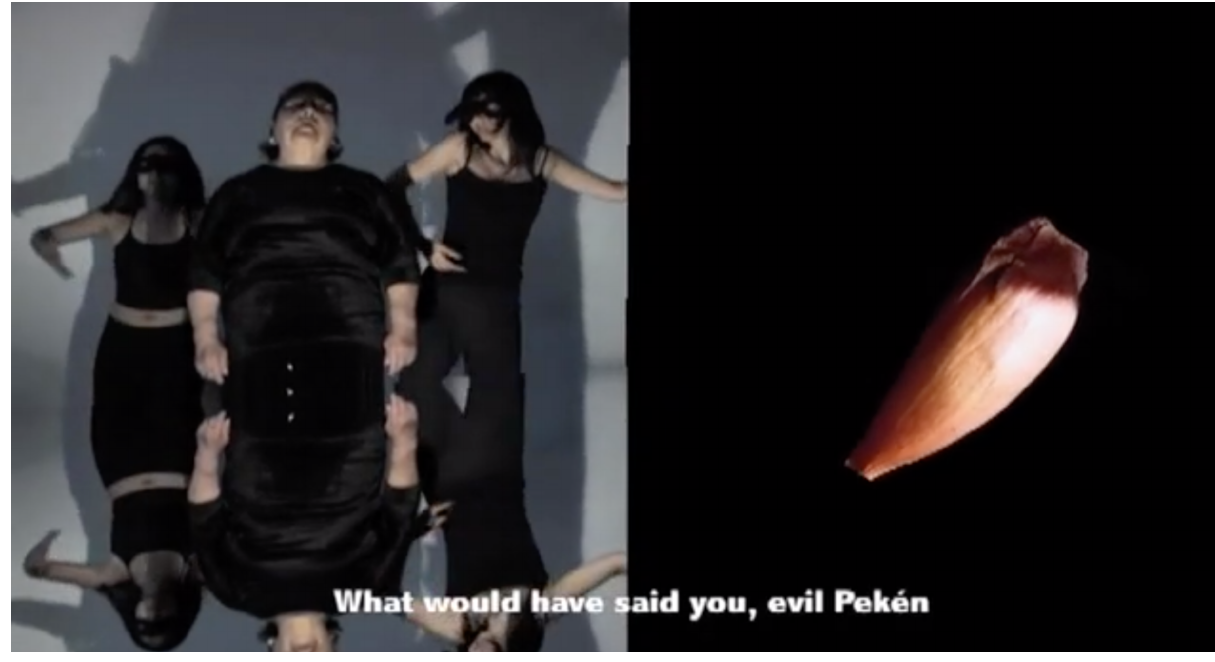
Figure 2: Still from Francisco Huichaqueo Pérez’s Che Uñum - Gente pájaro (2007) Video still courtesy of Francisco Huichaqueo Pérez. Film available at: https://vimeo.com/